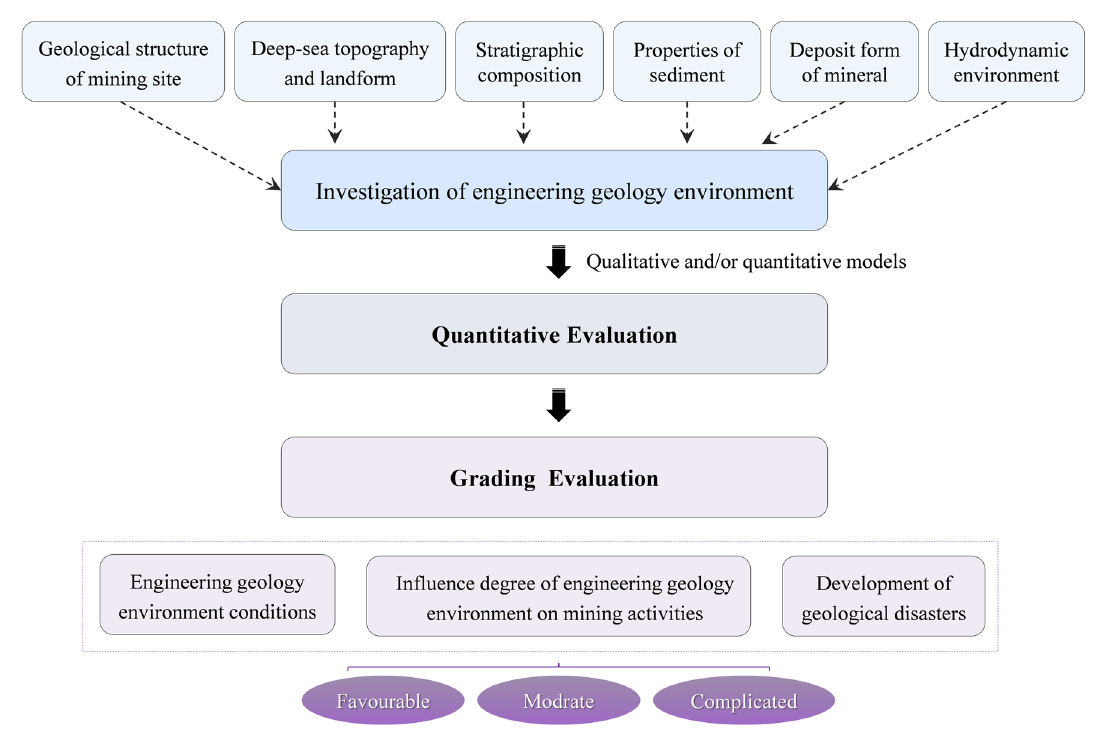
Fig. 15 Evaluation of the engineering geology environment of a deep seabed mining site